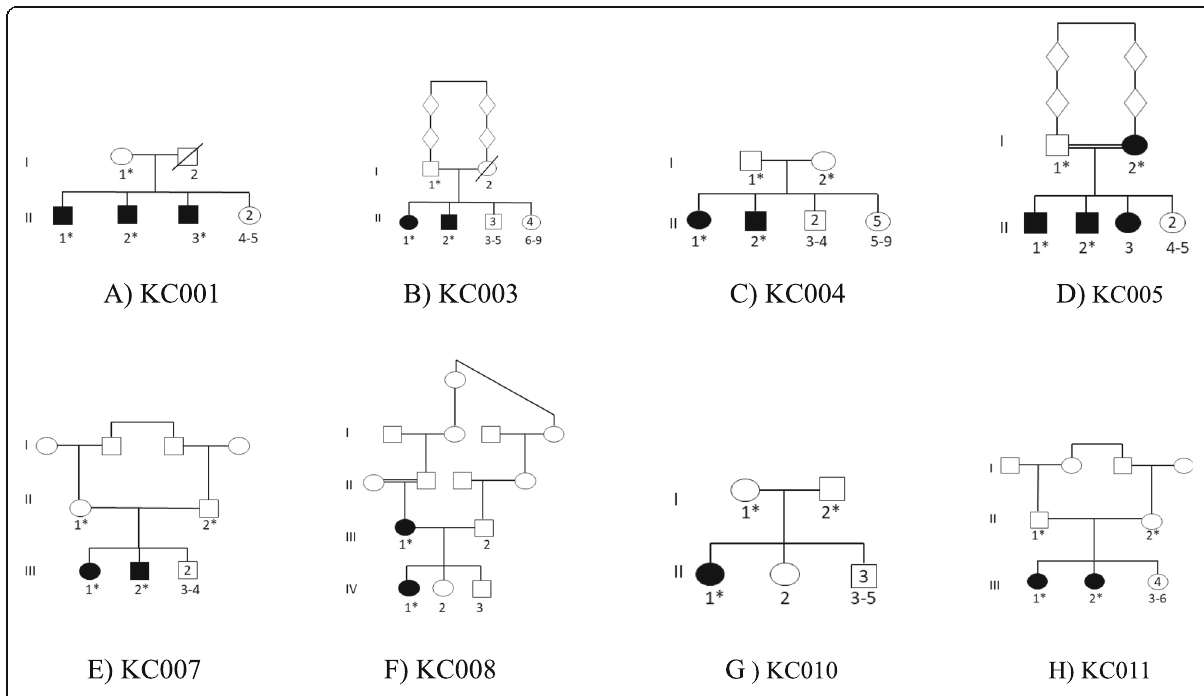
Fig. 2 Pedigrees of the recruited families. a Family KC001, b Family KC003, c Family KC004, d Family KC005, e Family KC007, f Family KC00 8, g Family KC010, h Family KC011 * Individuals included in the